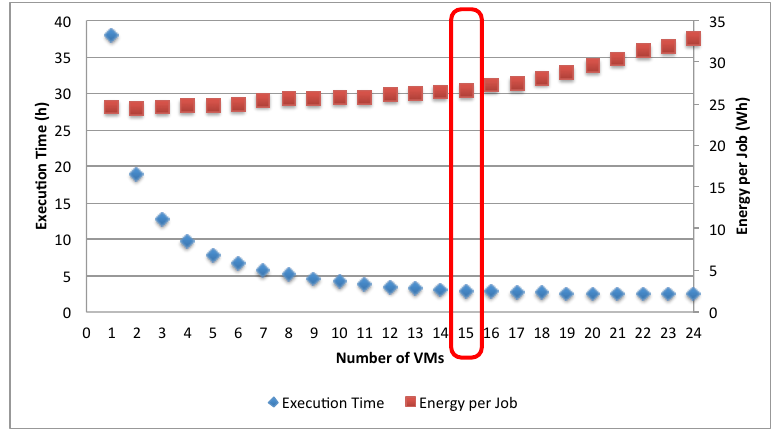
Figure 16. Execution time and energy per job with asynchronous